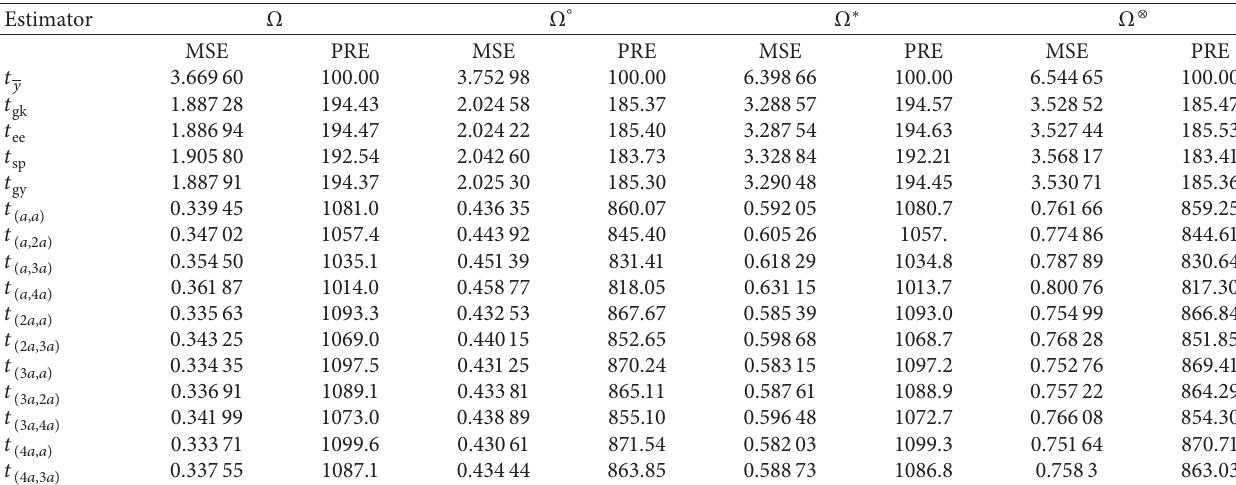
Table 3: MSE and PRE of the estimators for n �